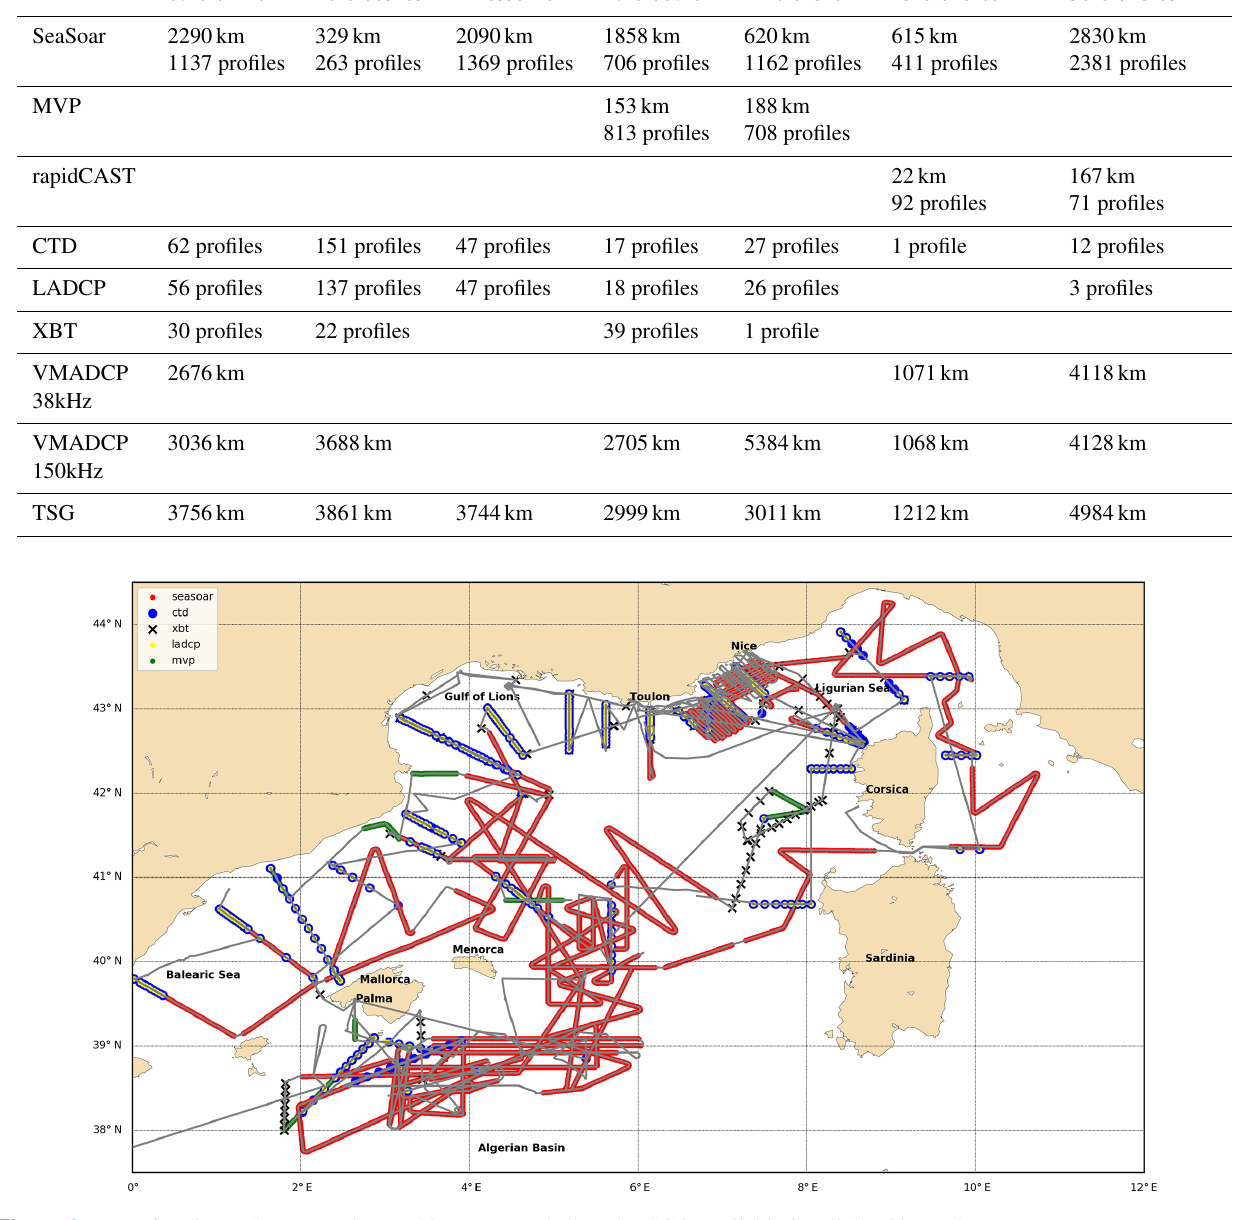
Figure 2. Map of PROTEVS-MED cruises and instruments deployed; TSG is available for all the ship